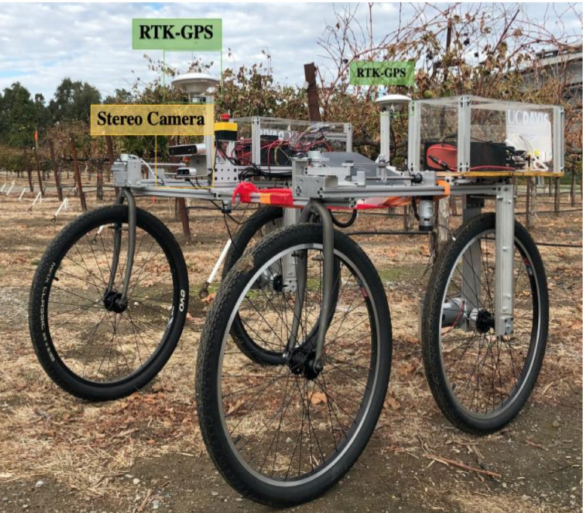
Figure 10. The mobile robot that was used as the experimental platform.